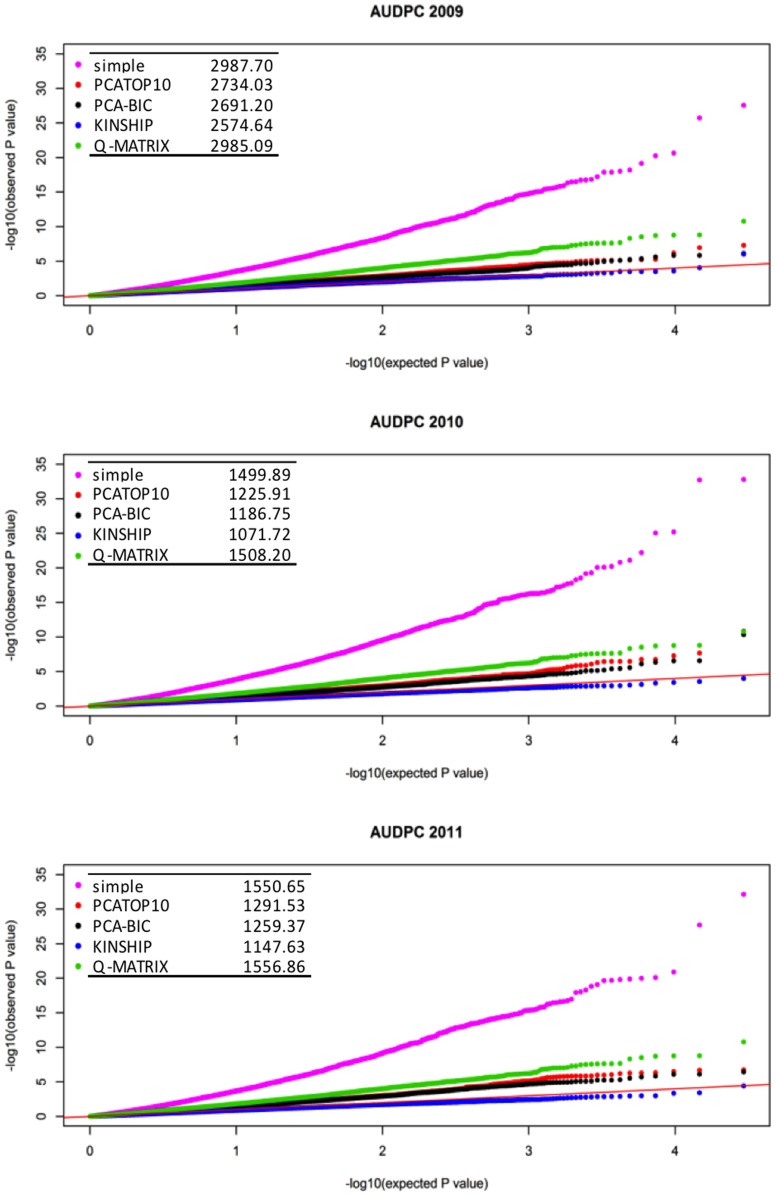
Quantile-quantile plots of expected and observed P values evaluating the type-1 error in a simple model (simple), the top ten principal components (PCA-TOP10), BIC selected PCs (PCA-BIC), the K model (KINSHIP), and the Q model (Q MATRIX) with goodness of fit test using Bayesian Information Criterion for 2009, 2010, and 2011 (top to bottom).